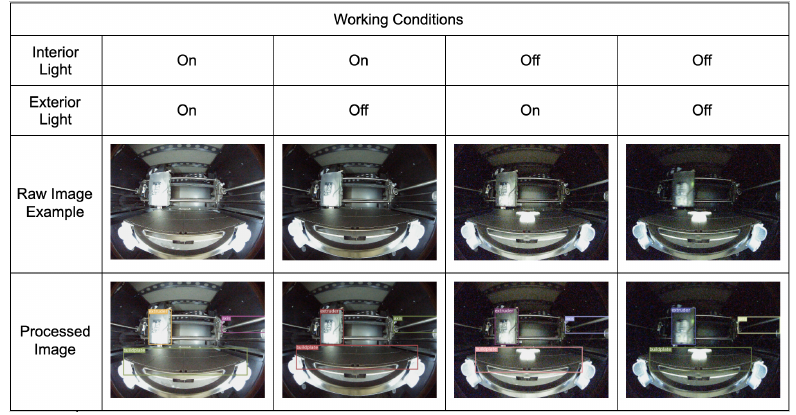
Figure 7. Some results on different working conditions. Table 2. The accuracy of DMM on the test dataset, where AP is average